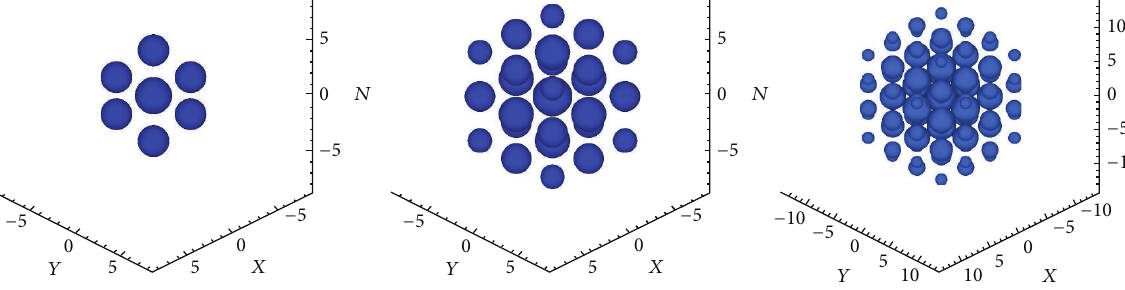
Figure 4: The isosurface plots of ground state in Example 3 for 𝛽 = 100, 𝛽 = 800, and 𝛽 = 6400.